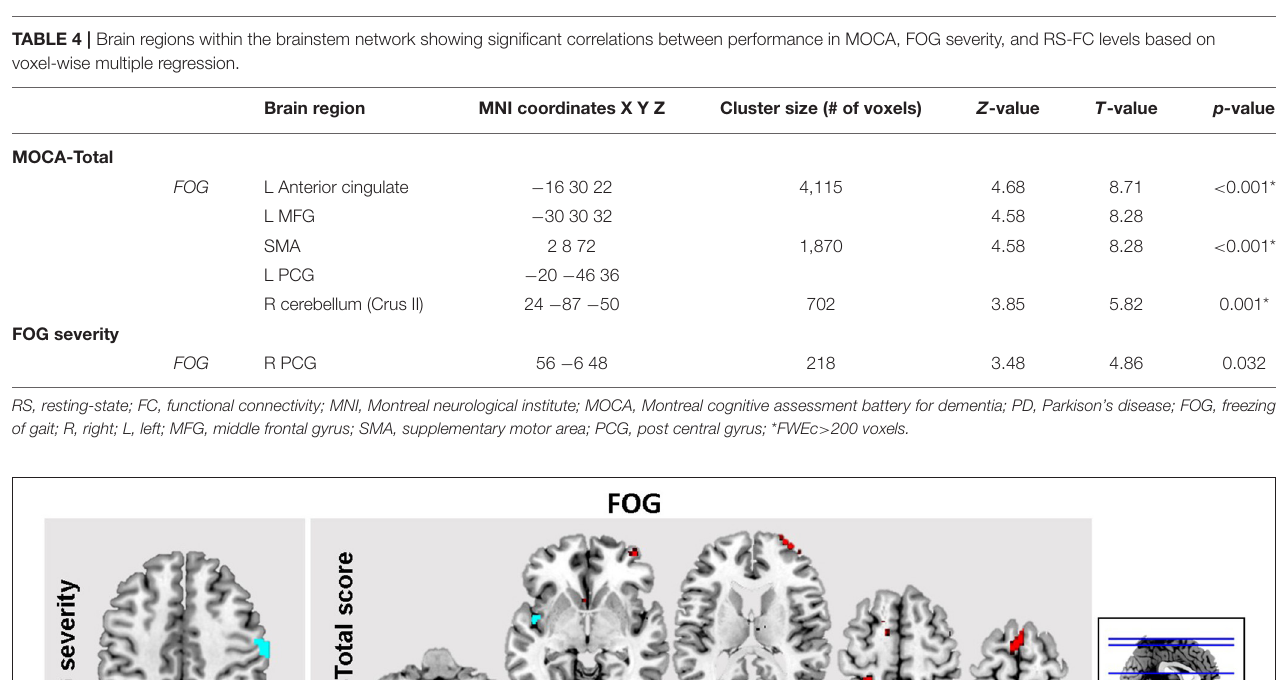
TABLE 4 | Brain regions within the brainstem network showing significant correlations between performance in MOCA, FOG severity, and RS-FC levels based on voxel-wise multiple regression. Brain region MNI coordinates X Y Z Cluster size (# of voxels) Z -value T -value p- value MOCA-Total FOG